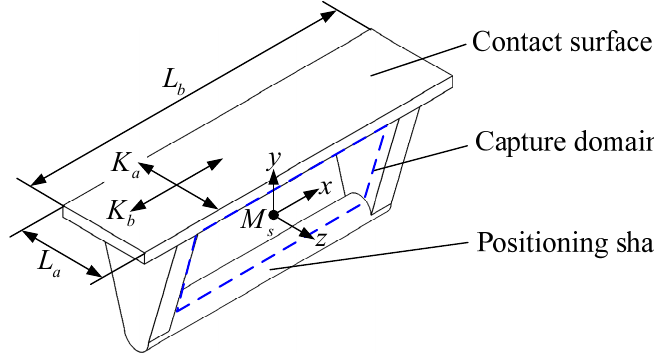
Figure 10. Schematic diagram of the capture frame configuration.